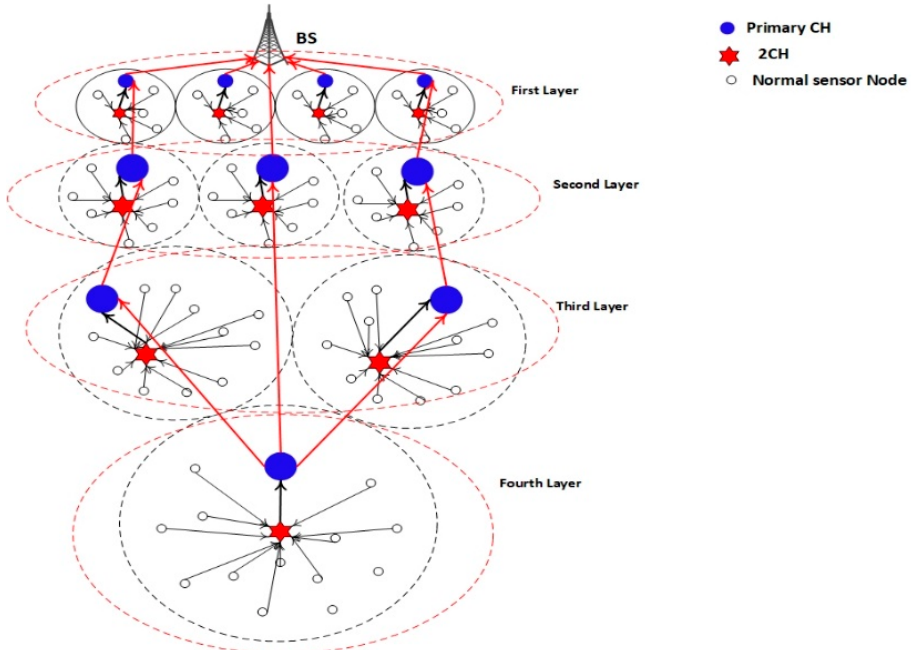
Figure 3. The network system design.